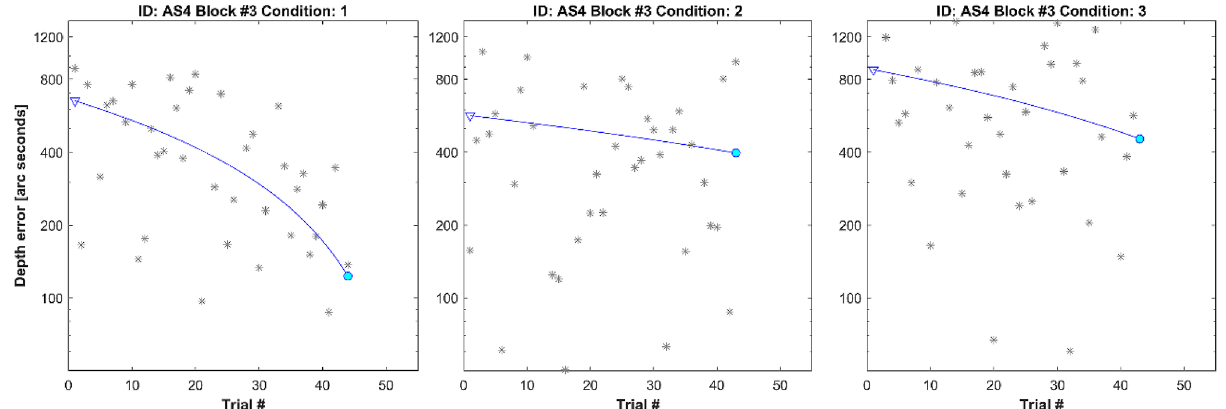
Figure 2. Within-block learning example (AS4, strabismic stereo-anomalous participant). From left to right, raw data in block number 3 under Condition 1, 2 and 3. Each asterisk represents depth error (arc seconds) from one trial. The continuous blue line represents a linear fit of the depth error at each trial. The triangle represents the start point and the circle the end